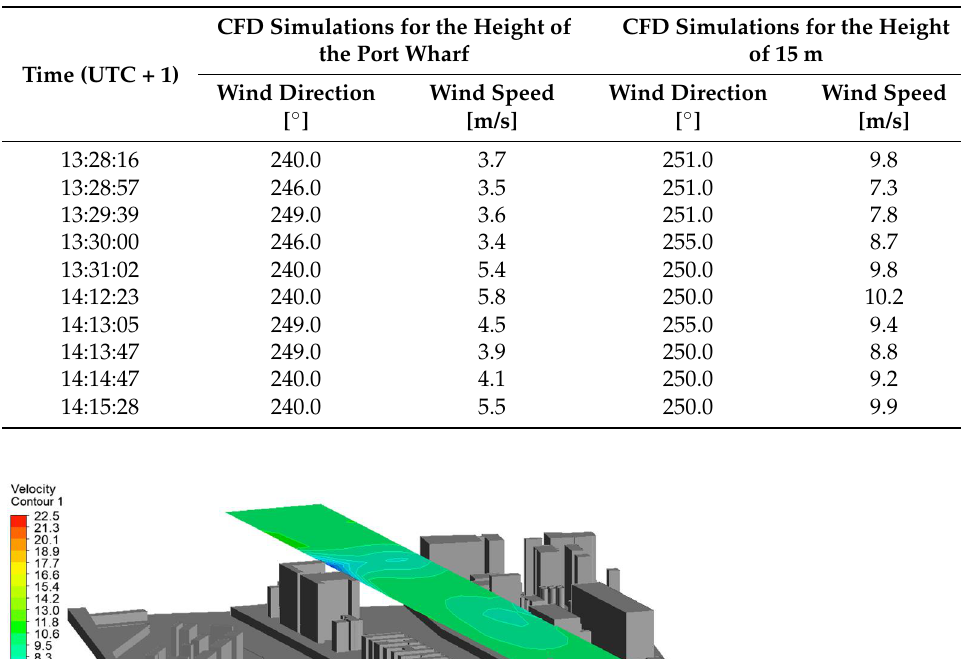
Table 4. Comparison of CFD simulation.